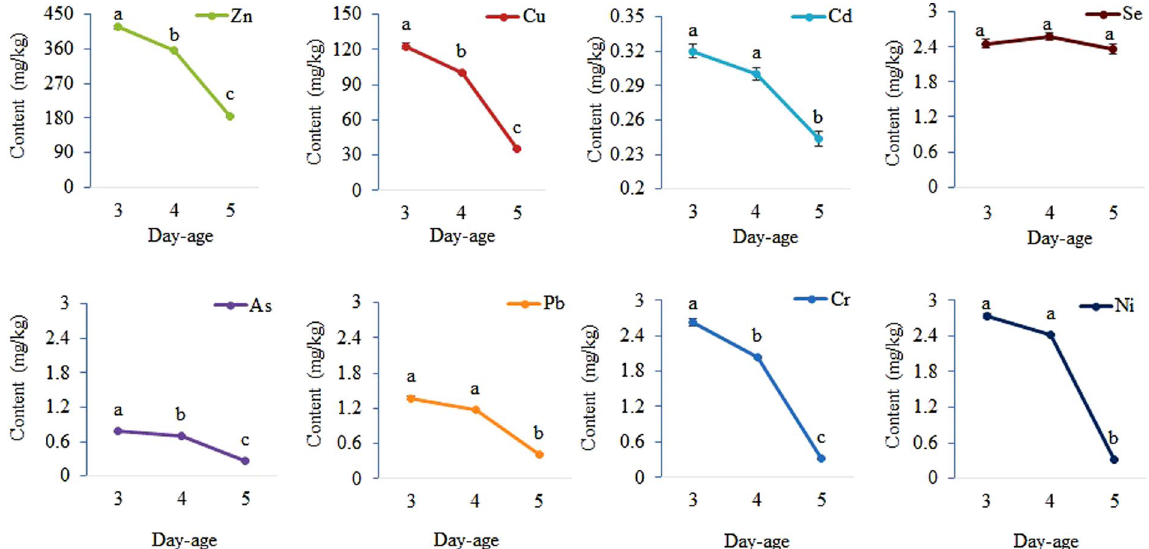
Figure 2. Heavy metal levels in maggots of different ages (days) fed swine manure. The mass represents the average content of heavy metals in maggots of different ages; the different letters on each line indicate the significant differences between treatments at P < 0.05 during different ages in